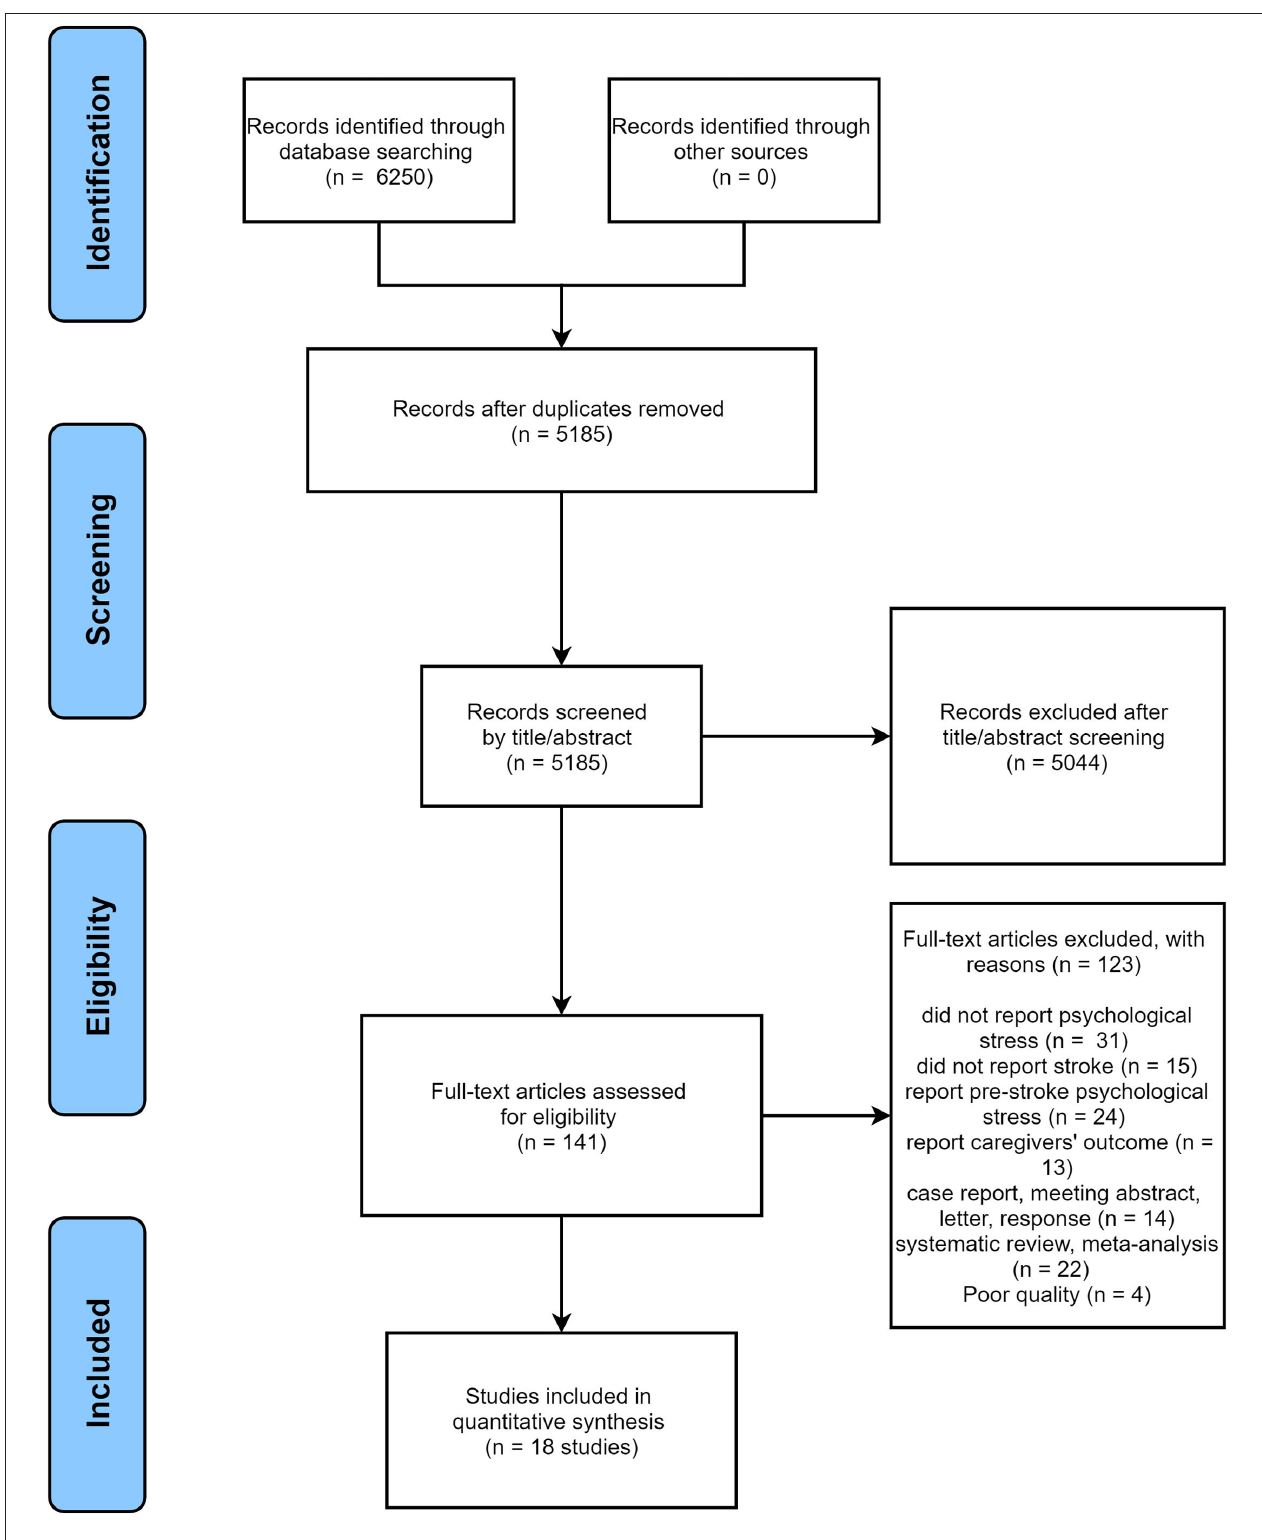
FIGURE 1 | Flow diagram of study